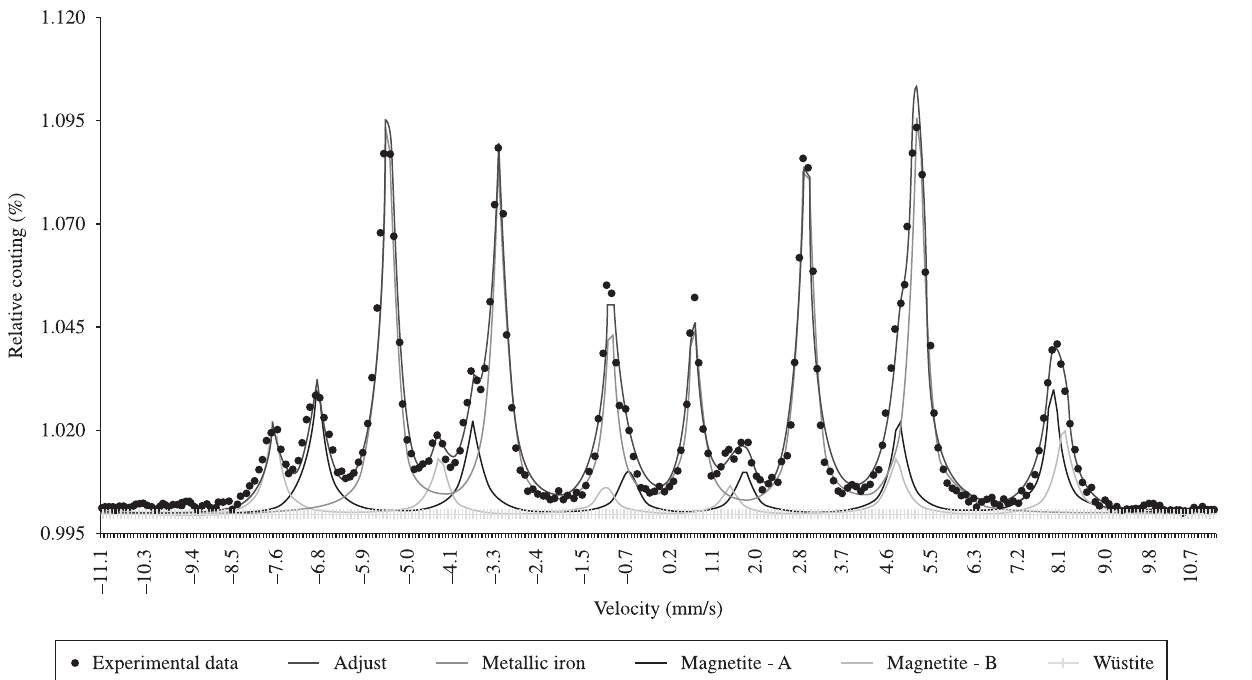
Figure 4. Obtained Mössbauer MIMOS II4 spectra adjusted by the least square method (sample A2: ISC at 20%; oil flow at +30%; slab thickness = 28